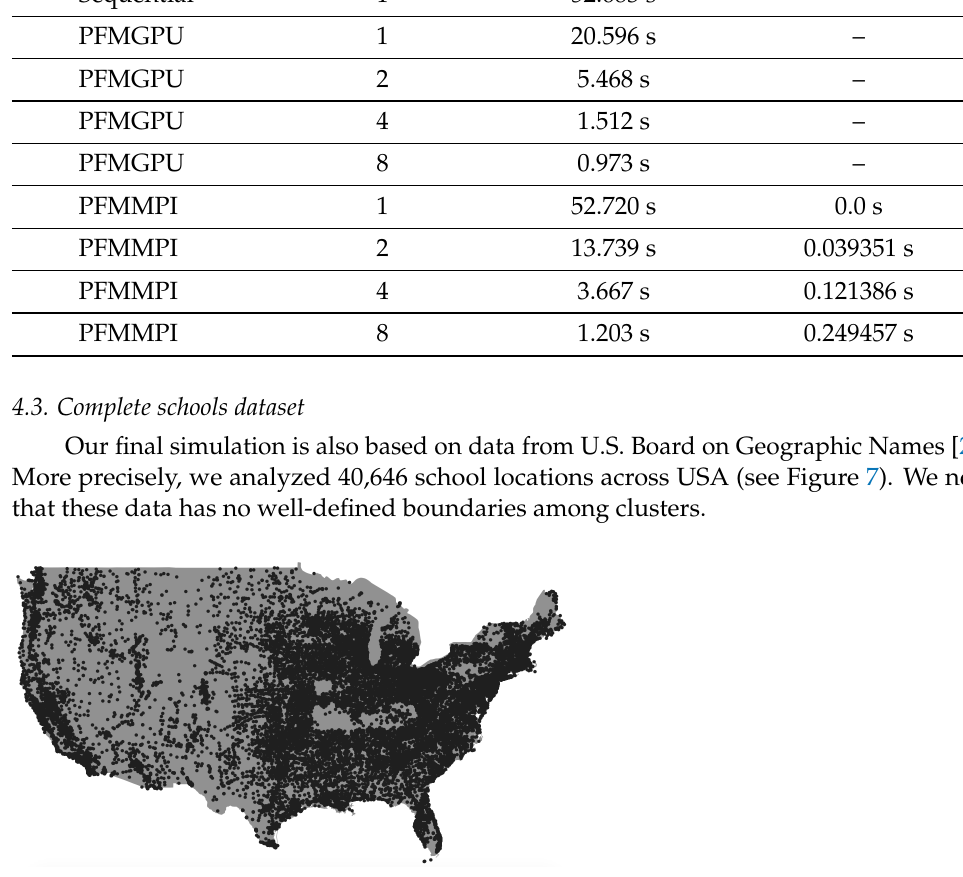
Figure 7. Geographical coordinates of 40,646 USA schools (complete schools dataset).